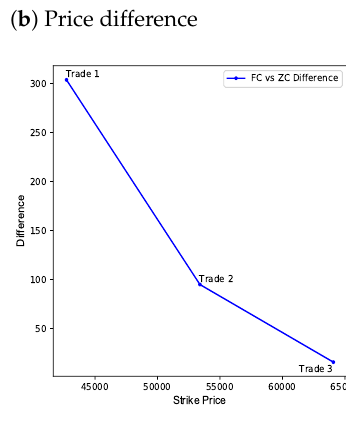
Figure 9. Zero collateral vs. fully collateralized trades.